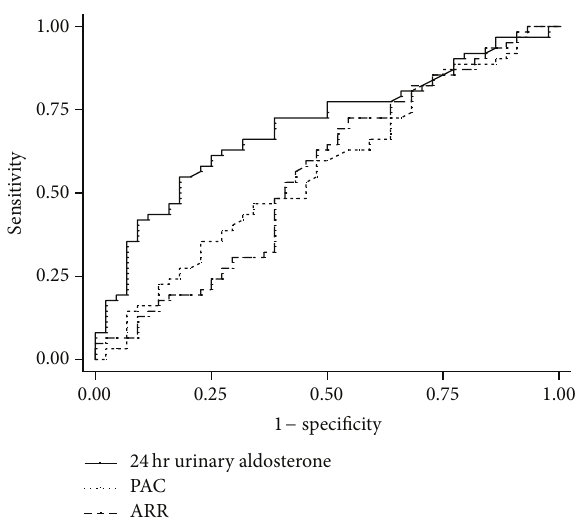
Figure 2: ROC curve: to predict the presence of inappropriate LVMI in patients with primary aldosteronism: the ROC AUC of log- transformed 24 hr urinary aldosterone is larger than that of PAC or ARR. (ROC AUC for log-transformed 24hr urine aldosterone: 0.61 (95% CI 0.48–0.734); for PAC: 0.43 (95% CI 0.31–0.551); for plasma aldosterone to renin activity ratio: 0.493 (95% CI 0.36–0.61), † 𝑃 < 0.01 compared with log-transformed urine aldosterone) The presence of inappropriate LVMI is defined as positive if measured to predicted LVMI ratio >